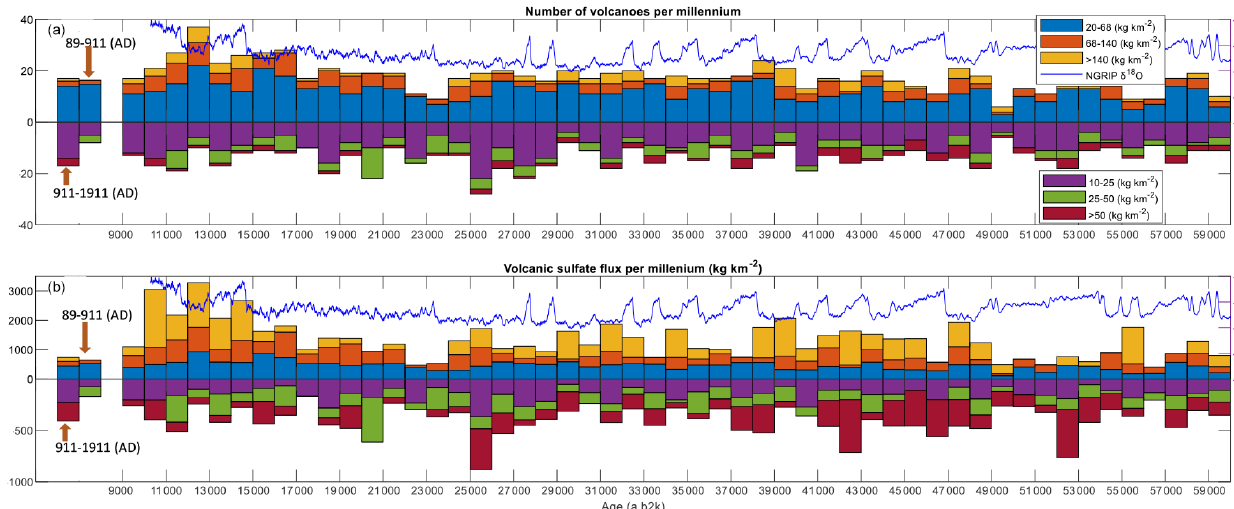
Figure 3. Number (a) and volcanic sulfate deposition (b) of volcanoes per millennium detected in Greenland and Antarctic ice-core sulfate records with relatively similar data resolution for the last 2500 years and the late glacial period. Positive values represent Greenland volcanoes, and negative values represent Antarctic volcanoes. The volcanic eruptions are grouped into three size fractions based on the 0.7 and 0.9 quantiles of the volcanic sulfate deposition distribution. For Greenland the classes are separated at 68 and 140kgkm − 2 , and for Antarctica the separation is made at 25 and 50kgkm − 2 . The magnitude of volcanoes is represented by the average volcanic sulfate deposition in Greenland or in Antarctica. The records used for the figure are as follows: for the last 2000 years (911–1911CE and 89–911CE), the volcanic sulfate deposition is based on the NEEM S1 and NGRIP cores for Greenland and on the WDC core for Antarctica (Sigl et al. 2013) using smoothed 2-year resolution sulfate records. For the period 60–9ka the Greenland sulfate deposition is derived from NEEM, GISP2 and NGRIP. For GISP2, the data were smoothed to 5 years in the period of 14–9ka, and for the period older than 14ka only large volcanic sulfate signals are detected. The NGRIP sulfate record has been smoothed to 2-year resolution throughout. For the period 60–9ka the Antarctic sulfate deposition is derived from EDML, EDC and WDC sulfate records. The WDC sulfate record has been smoothed to 2-year resolution.